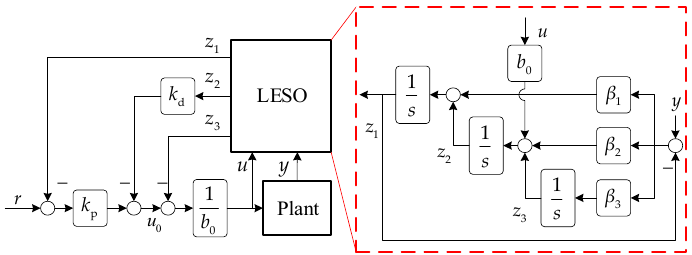
Figure 3. Structure of original LADRC-based voltage control